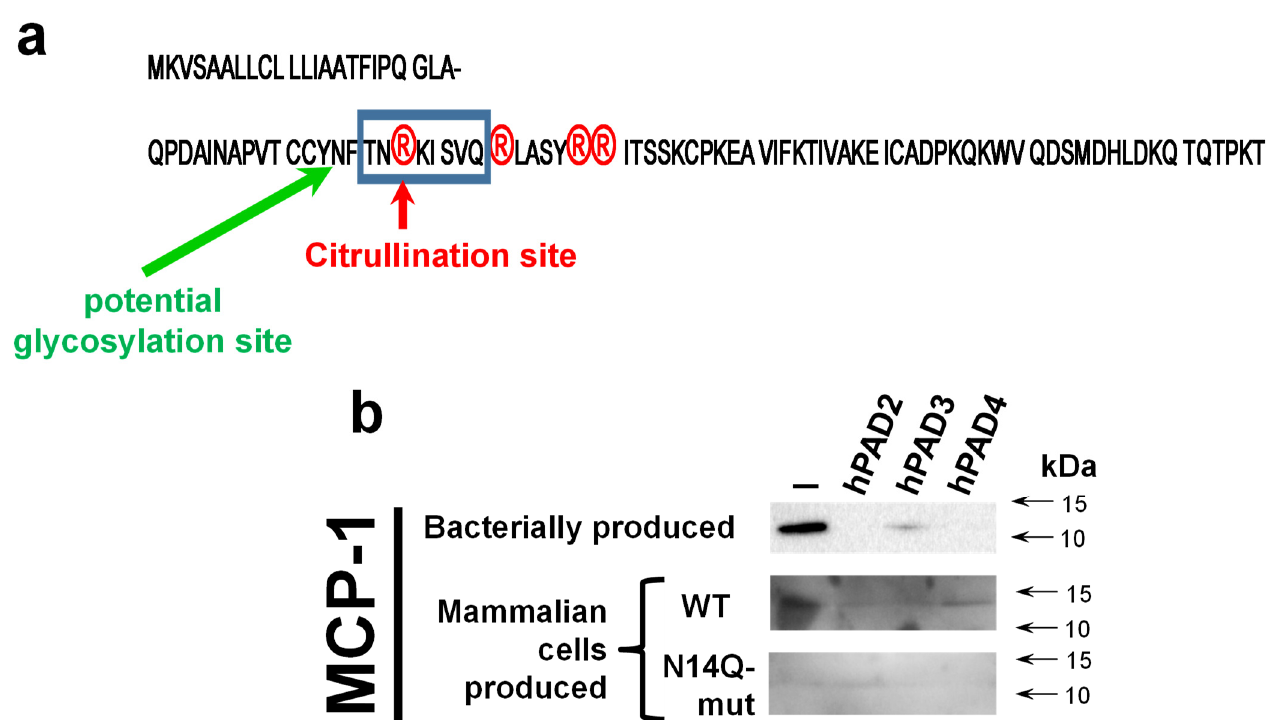
Figure 4. Site-directed mutagenesis of potential glycosylation site at asparagine-14 in mammalian cell-produced MCP-1 significantly destabilizes recombinant human MCP-1/CCL2. ( a ) Amino acid sequence of MCP-1/CCL2 with indicated positions of predicted N-glycosylation and citrullination site confirmed by a mass-spectrometry. ( b ) Immunoblot analysis of bacterially versus mammalian cell-produced MCP-1/CCL2 upon an in vitro citrullination reaction. Bacterially produced wild-type MCP-1/CCL2 or HEK293T cell-produced wild-type and N14Q mutant version of chemokine were incubated with EDTA-free proteinase inhibitor cocktail supplemented cellular lysates prepared from the control (vehicle-transfected) or indicated hPAD enzyme-transfected HEK293T cells. Citrullination reactions that were performed directly within cellular lysates essentially as published before [21]. Recombinant chemokine was concentrated with immunoprecipitation and resolved on 10–18% polyacrylamide gradient SDS-PAGE. Results shown are a representative of three experiments.